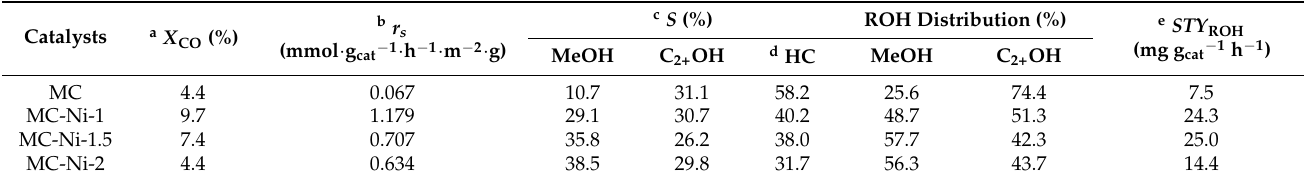
Table 2. The catalytic performance of the catalysts.